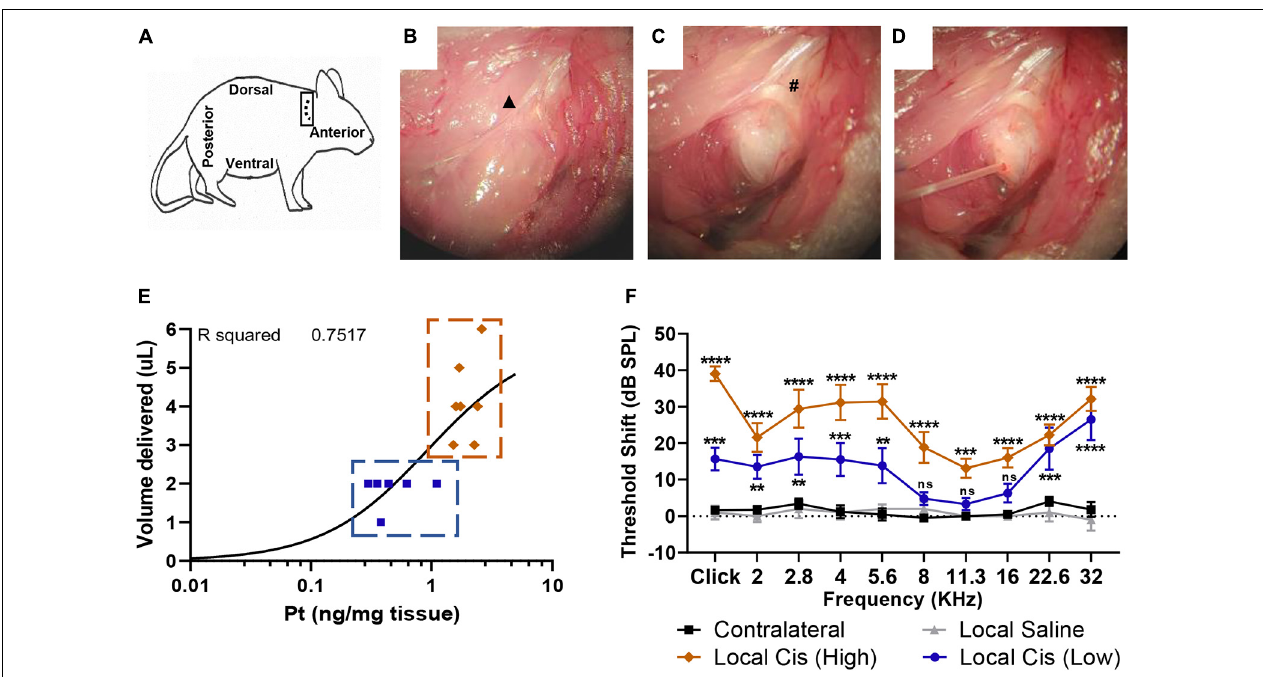
FIGURE 1 | Minimally invasive, retroauricular approach for local cisplatin delivery. To access retroauricular position of bulla, mouse is placed in lateral position, with right ear upward. An incision is made retroauricularly (A) . After skin retraction, cervical trapezius muscle and great auricular nerve ( (cid:78) ) are exposed (B) . After careful dissection of connective tissue, bulla bone and facial nerve ( # ) are identified (C) . Access hole is drilled in a posterior-dorsal position, minimizing risk for cochlear damage. A 0.3-mm diameter cannula is placed into bulla aperture (D) to deliver 2–5 µ l of solution. Finally, a piece of tissue and cyanoacrylate glue are used to occlude the opening. (E) Correlation plot ( n = 13) between cisplatin (5 mM) volume delivered (limited by bulla size) and Pt fixation. Animals with a volume of cisplatin < 3 µ l were classified in “low cisplatin” subgroup (blue), whereas animals with a volume of cisplatin ≥ 3 µ l were classified in “high cisplatin” subgroup (orange). (F) Permanent threshold shift, measured by unilateral auditory brainstem response (ABR), in cisplatin-treated animals (5 mM, n = 13) was recorded 7 days after local delivery in comparison with delivery of saline solution ( n = 5) and contralateral untreated ears. Cisplatin treated animal data were represented following “high” (orange) and “low” (blue) subclassification defined on (E) . The confidence interval for both statistics was set as 95% ( a = 0.05); ∗∗ p < 0.01; ∗∗∗ p < 0.005; ∗∗∗∗ p <